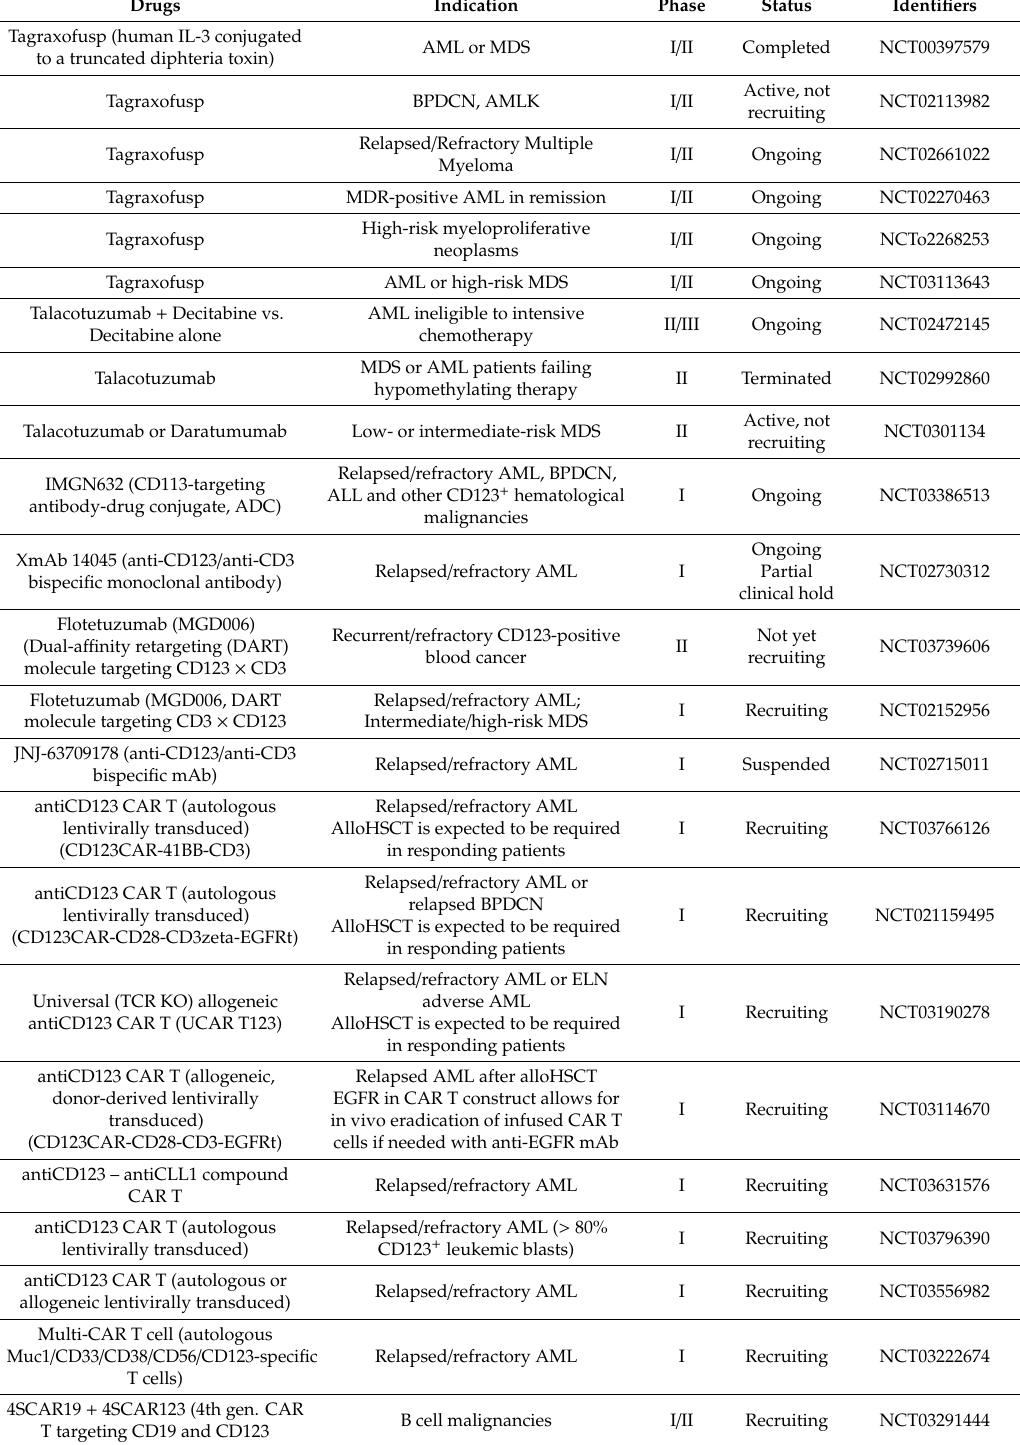
Table 2. Therapeutic targeting using anti-CD123 monoclonal antibodies, interleukin-3 (IL-3) conjugated diphtheria toxin, CD3 × CD123 bispecific antibodies and dual-a ffi nity re-targeting (DART) and chimeric antigen receptor (CAR) therapies related to